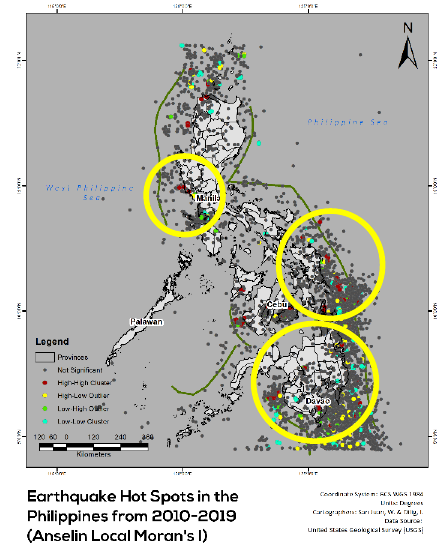
Figure 16. Earthquake Hot Spots in the Philippines from 2010 to 2019 (Anselin Local Moran’s I)